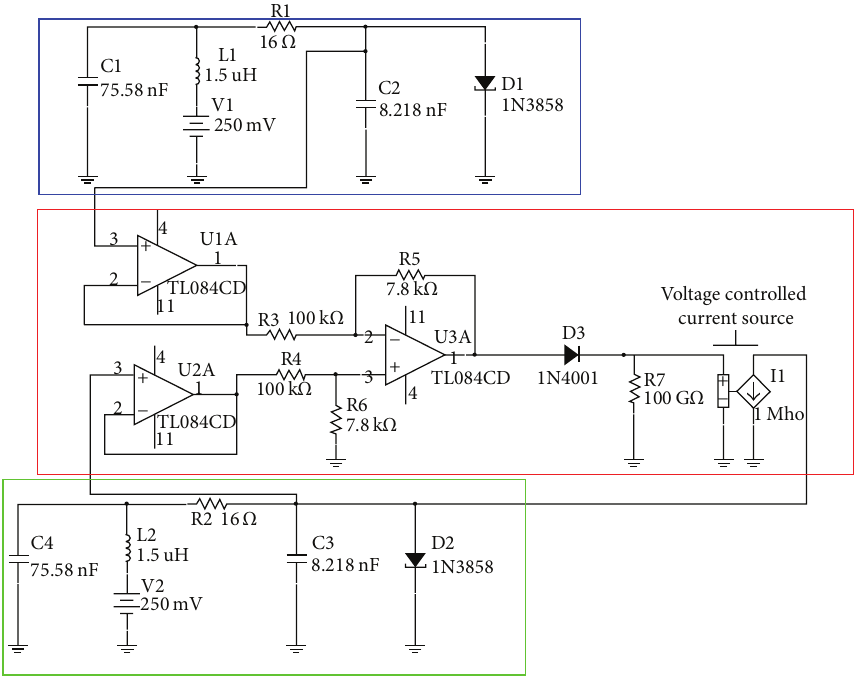
Figure 1: Scheme of the circuit for the whole system: transmitter (blue box), controller (red box), and receiver (green box).